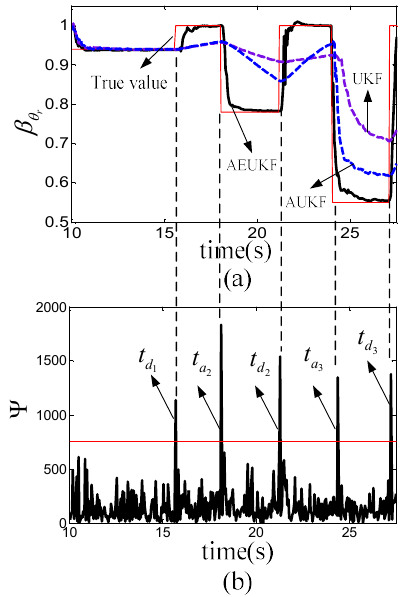
Figure 9. Estimation results: ( a ) Estimate of β θ r ; ( b ) Response of Ψ